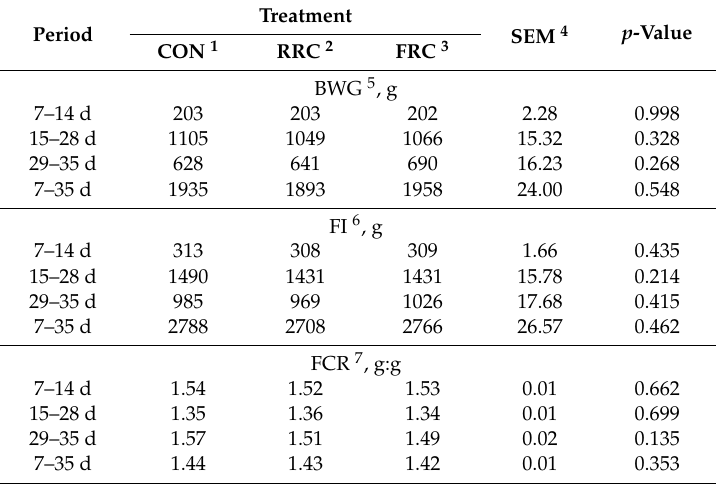
Experiment 1: Table 4 shows the growth performance results. In the first (days 7–14), second (days 15–28), and third period (days 29–35), and during the entire experimental period (days 7–35), none of the between-group di ff erences in BWG, FI, or FCR were statistically significant ( p > 0.05). Table 4. E ff ects of raw or fermented rapeseed cake on the growth performance of broiler chickens; experiment